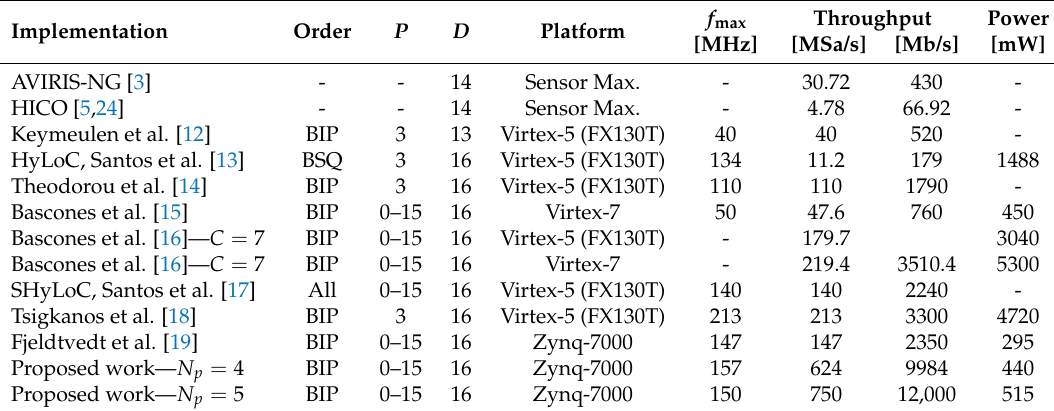
Table 4. Performance comparison of CCSDS-123